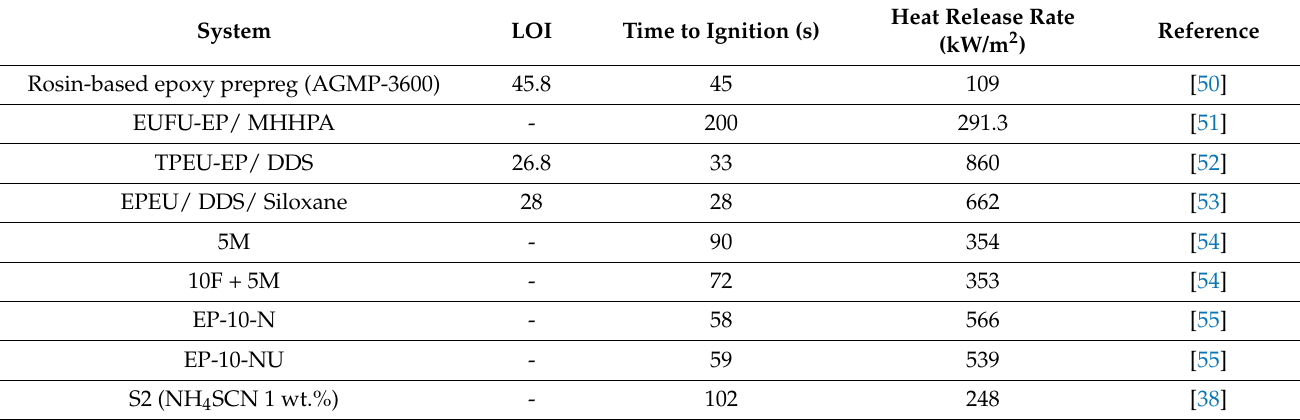
Table 4. Comparative study of the